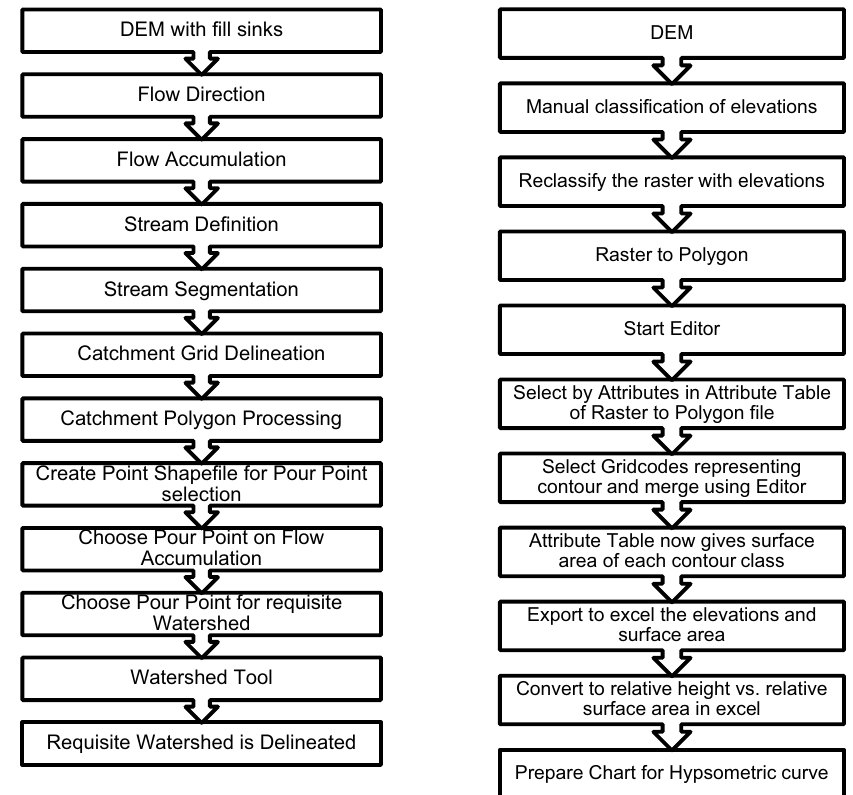
Fig. 4 Steps to delineate watershed, stream network and hypsometric curve in ArcGIS